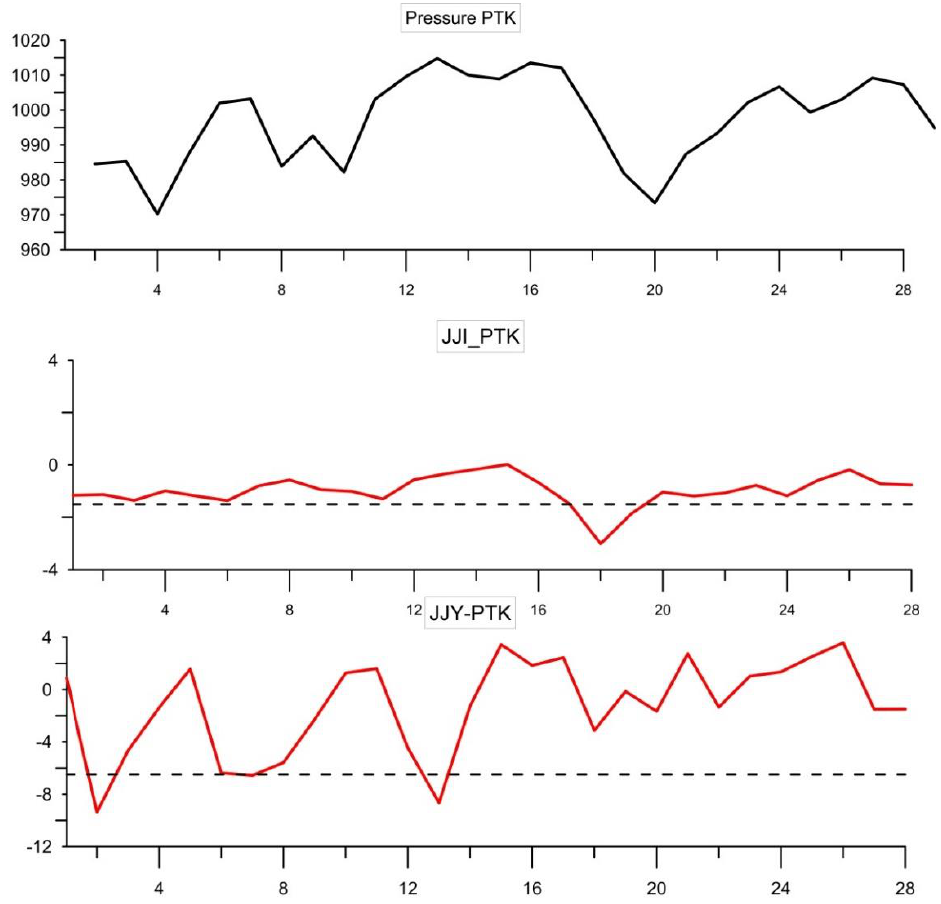
Figure 14. VLF/LF propagation anomaly for the first February EQ. The first plot depicts the temporal variation (as a function of day) of atmospheric pressure at Kamchatka in hPa. The second and third panels refer to the daily variations of signal amplitude (in relative unit) for the two propagation paths of JJI-PTK and JJY-PTK. The horizontal dotted lines indicate − 2 sigma lines (sigma is standard deviation), and amplitudes below this threshold are regarded as VLF/LF anomalies.